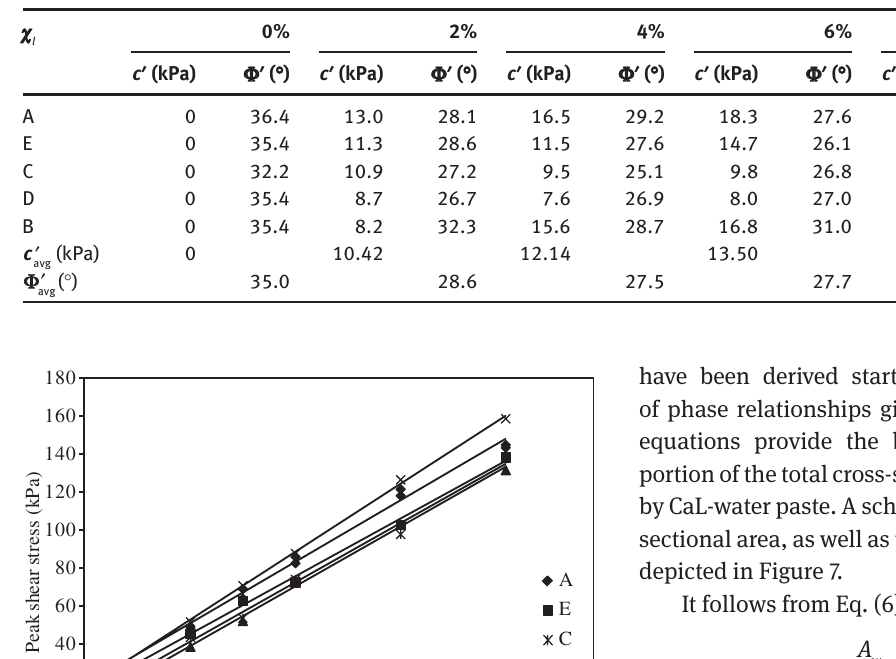
Table 1 Values of effective cohesion and friction angle for all test points.